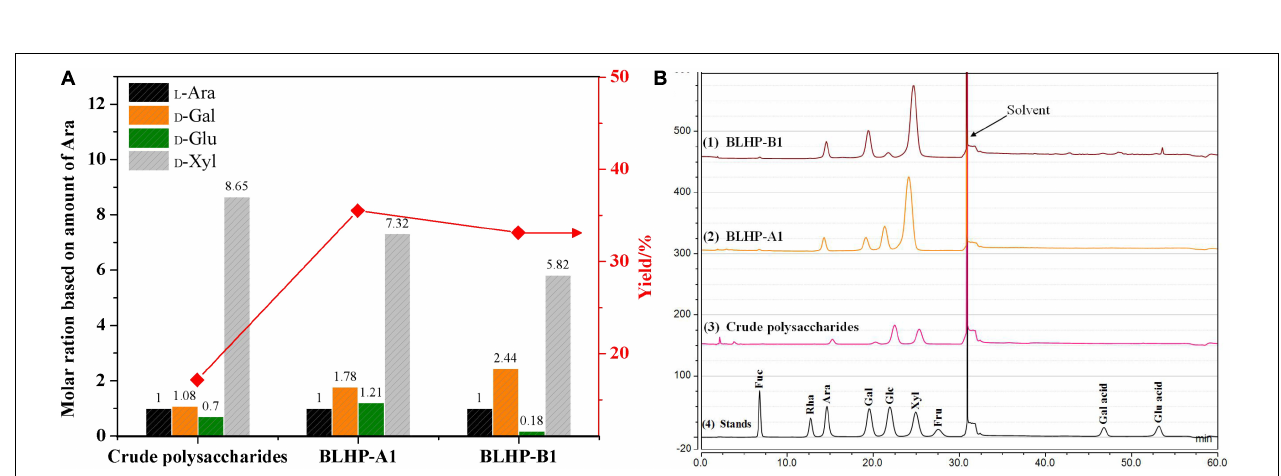
FIGURE 2 | The monosaccharide content in crude polysaccharides, BLHP-A1 and BLHP-B1 samples. (A) The relative molar ratios of monosaccharides among three samples based on the molar of arabinose. (B) HPACE spectrum for monosaccharide detection. All the samples were prepared at concentrations of 1.0 mg/ml.